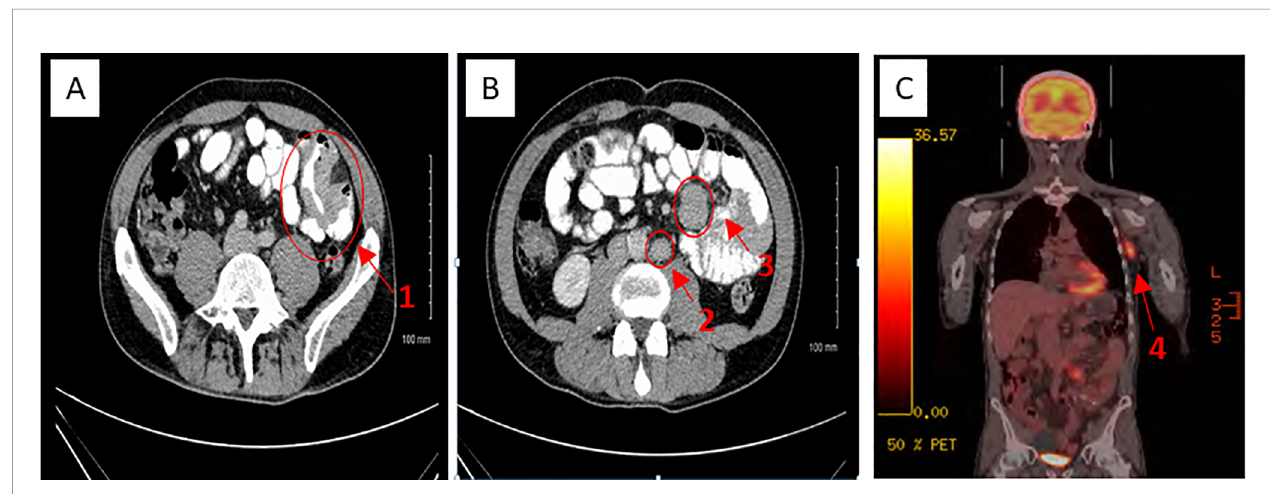
FIGURE 1 | CT (A, B) and PET-CT (C) appearances of metastatic jejunal melanoma. 1 = Metatstatic jejunal small bowel obstruction. 2 = Retroperitoneal lymphadenopathy. 3 = Multifocal small bowel mesenteric melamona. 4 = Metastatic left axillary